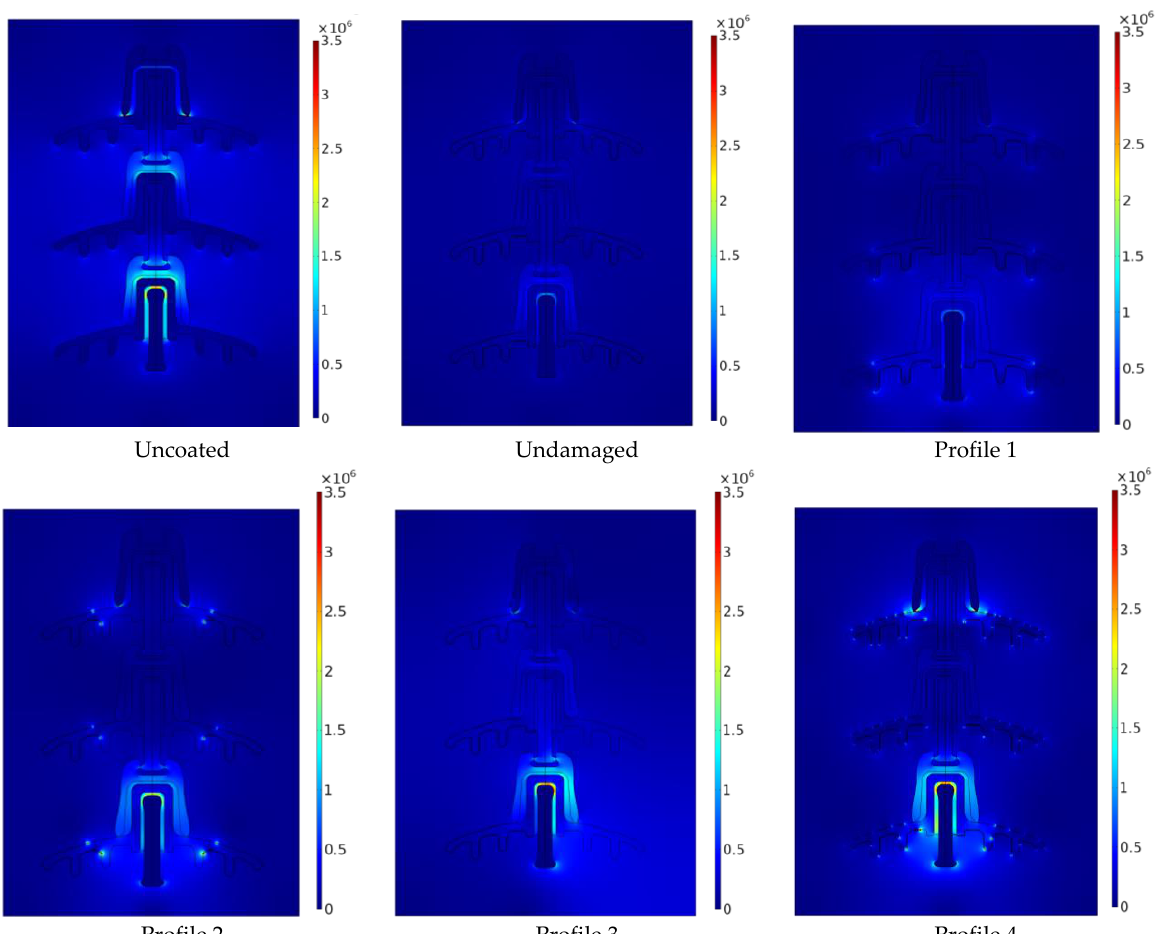
Figure 13. Electric field distribution of insulators with different profiles of